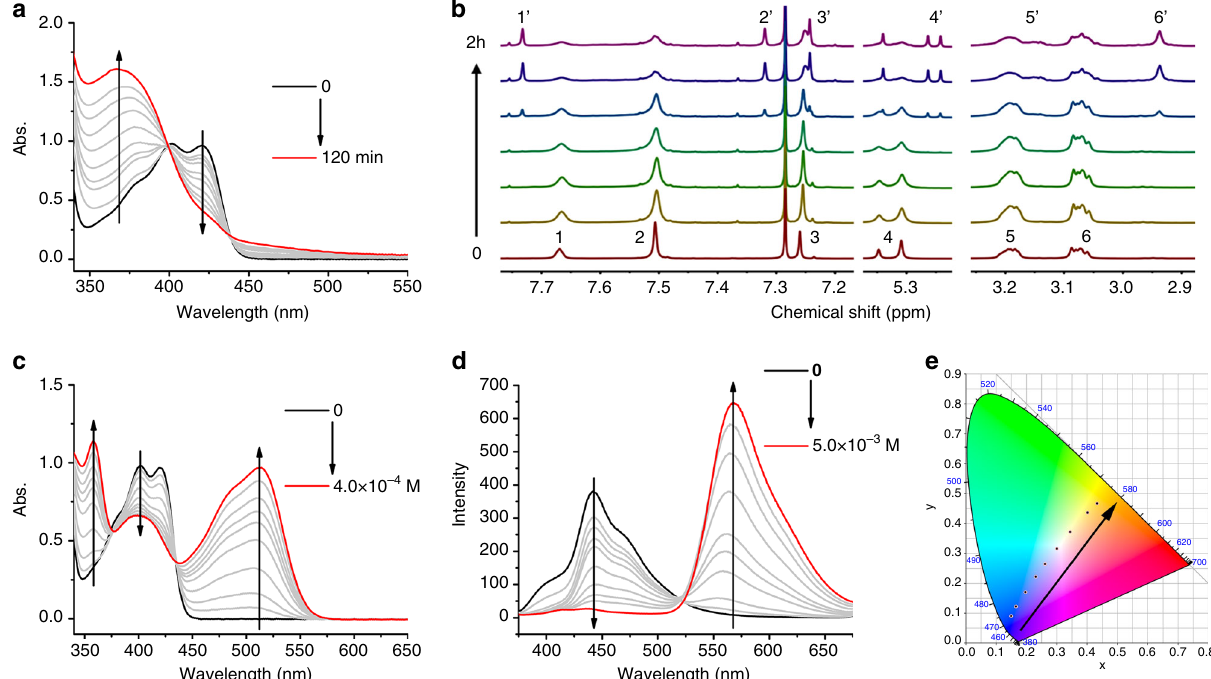
Fig. 2 The photoisomerization and protonation reaction of DSP-OH. a UV – vis spectra of 4.0×10 − 5 molL − 1 DSP-OH toluene solution for different irradiation times of 450nm light. b 1 H NMR spectra of DSP-OH for different irradiation times of 450nm light in CDCl 3 . c UV – vis spectra of 4.0×10 − 5 molL − 1 DSP-OH toluene solution with different concentration of CF 3 COOH. d Fluorescence emission spectra of 1.0×10 − 6 molL − 1 DSP-OH toluene solution with different concentration of CF 3 COOH. e The fl uorescence color of 1.0×10 − 6 molL − 1 DSP-OH toluene solution with different concentration of CF 3 COOH is illustrated in the CIE color